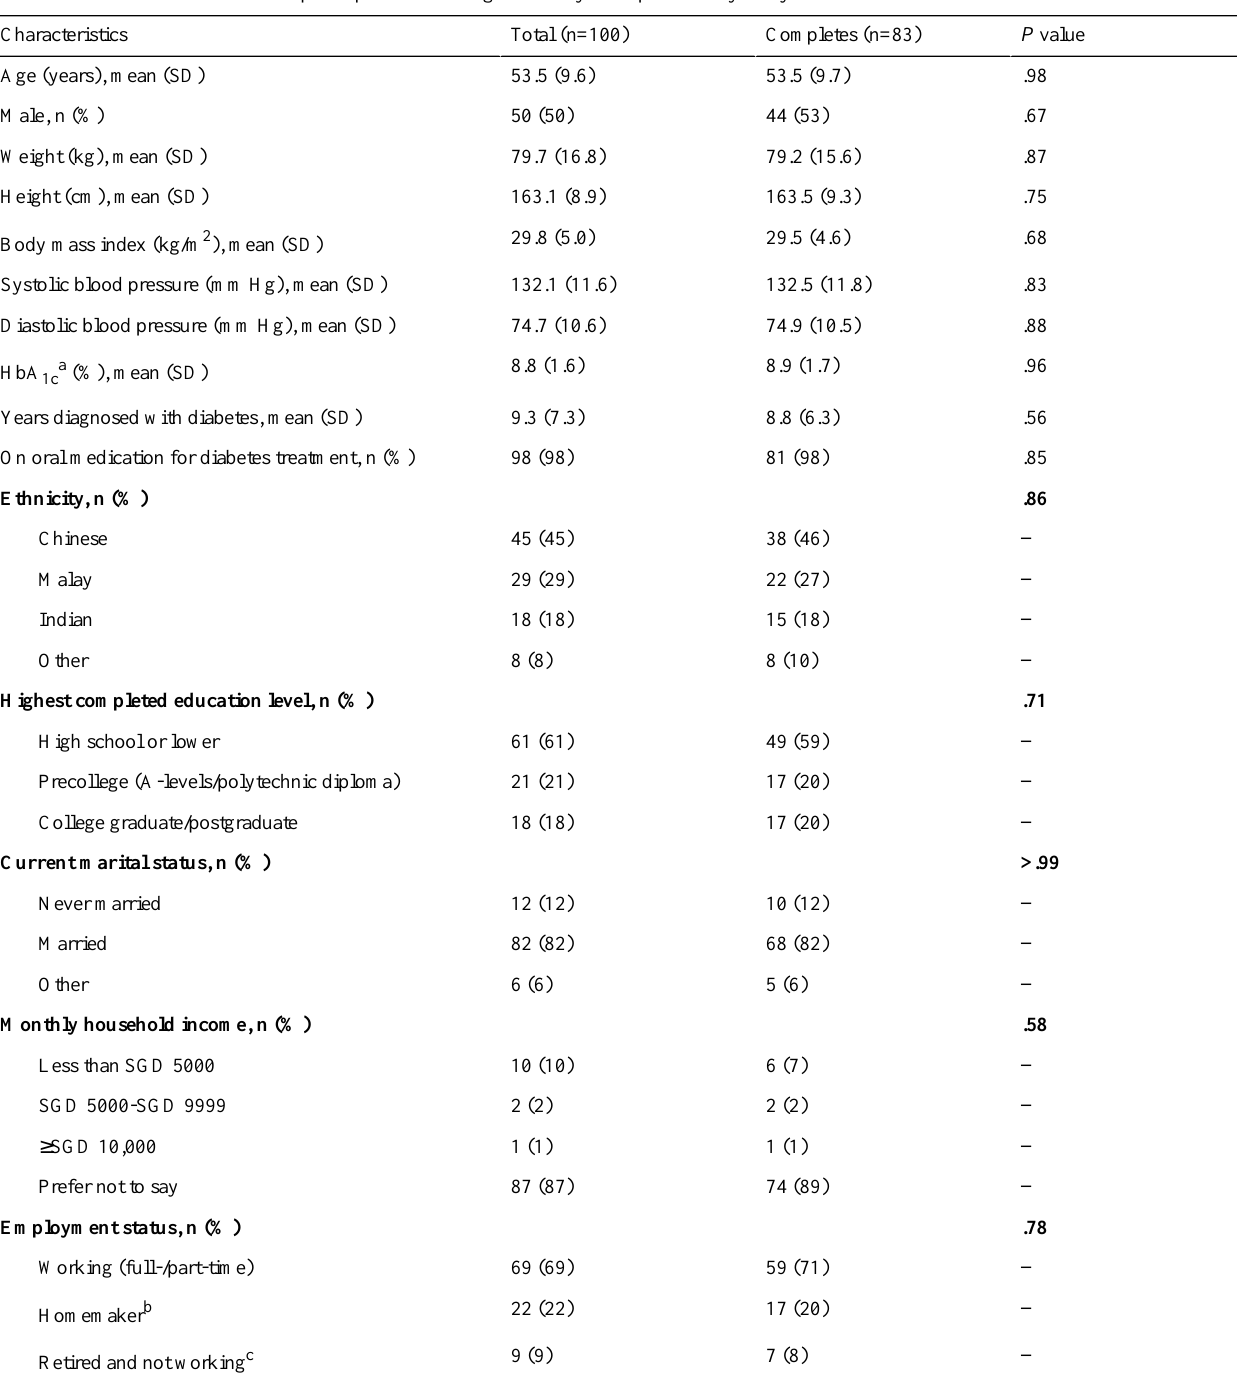
Table 2. Baseline characteristics of participants in the single-arm GlycoLeap feasibility study.